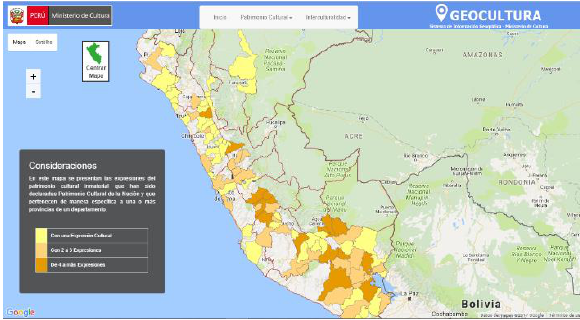
Figure 3. Interactive map: Flight of drones and virtual tours. Peru. Sistema de Información Geográfica-Geocultura. Google. Image: Screen